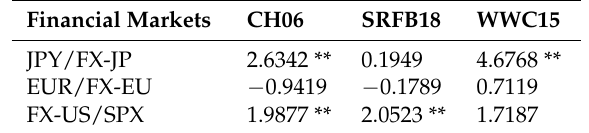
Table 4. Test statistics for stationary fractional cointegration in each financial market.